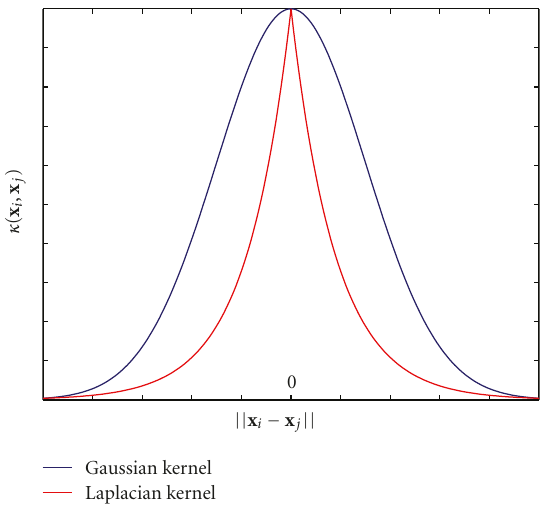
Figure 1: Shapes of the Gaussian and the Laplacian kernels around the